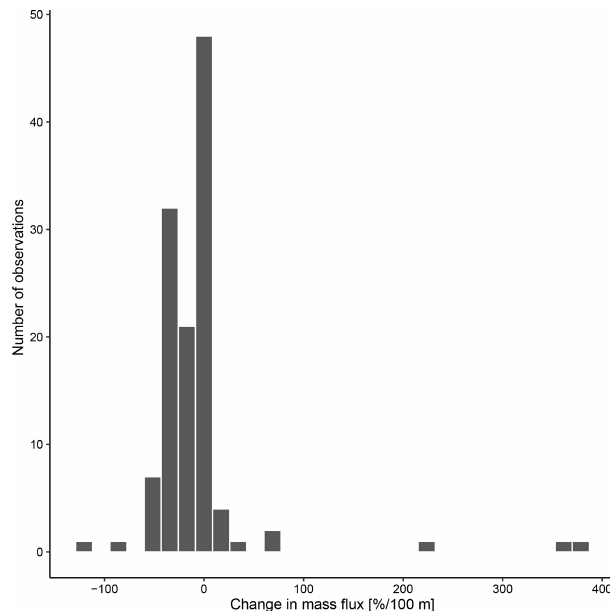
Figure 8. Change in mass flux between the net directly below the calculated base of the productive zone and the deepest net of sam- pling of each